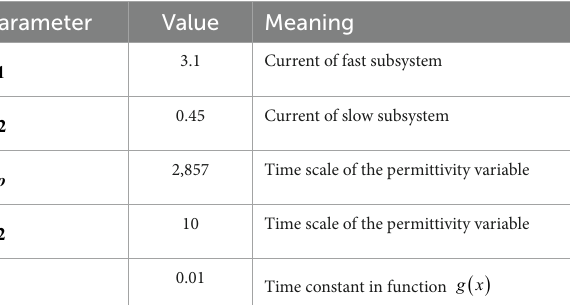
TABLE 1 Model default